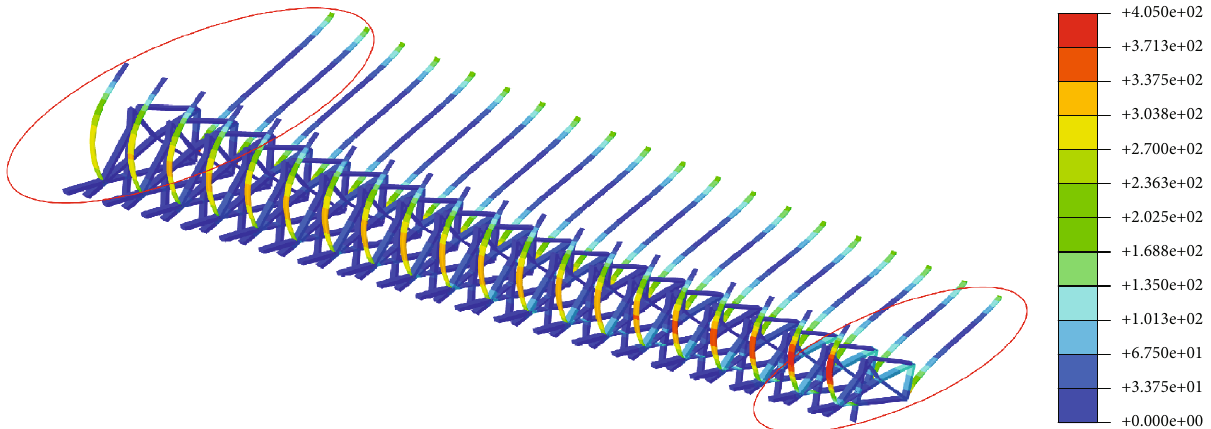
Figure 10: Stress distribution in the compliant ribs for the complete